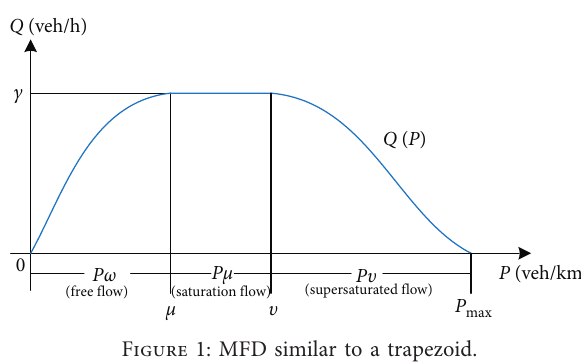
Figure 1: MFD similar to a trapezoid.